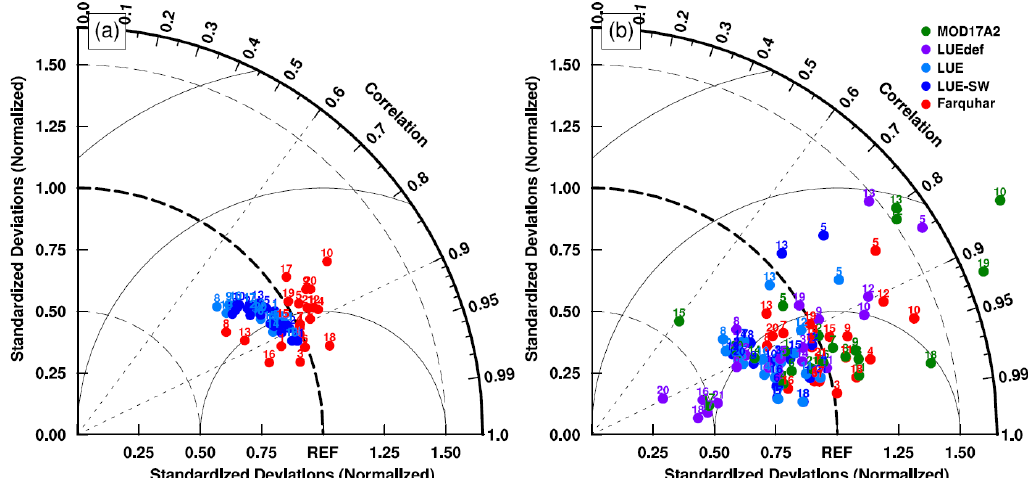
Figure 1. Performances of the GPP models for the 21 selected tower sites (Table 1). The statistics in the Taylor diagram were derived from the simulated and observed GPP of the representative year for each site: ( a ) half-hourly values and ( b ) 8-day average values. An ideal model has a standard deviation ratio ( σ ) of 1.0 and a correlation coefficient of 1.0 norm (REF, the reference